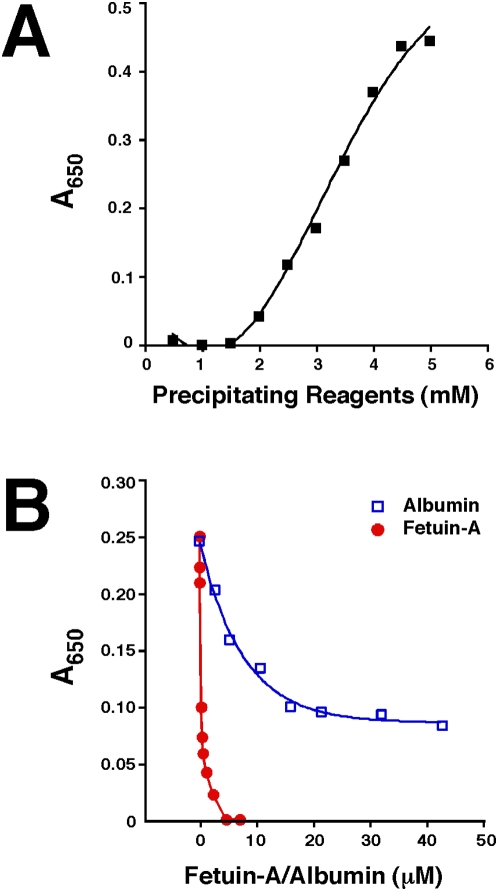
Inhibition of NLP formation by fetuin-A and albumin.(A) NLP were prepared from 0.5 mM to 6 mM each of CaCl2, Na2CO3, and NaH2PO4 added to water. A650 readings using a spectrophotometer show dose-dependent increase in optical density with NLP formation that displays a linear relationship seen between 2 and 4 mM of precipitating reagents used. (B) The inhibitory effects of fetuin-A and albumin on NLP formed in water were studied using 3 mM each of the three precipitating reagents. BSF or HSA were added to the indicated concentrations prior to the addition of the precipitating reagents. Compared to HSA, BSF showed markedly higher inhibitory potency on NLP formation.